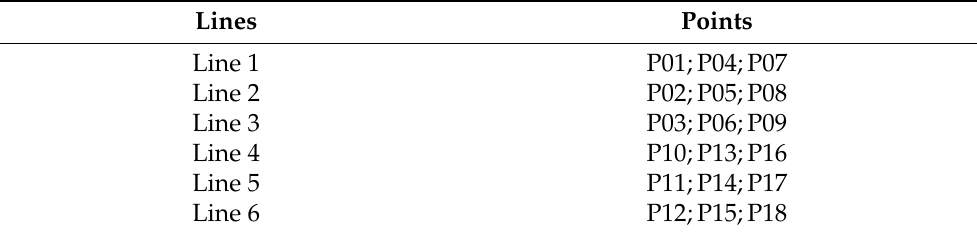
Table 1. Gas concentration evaluation points and corresponding